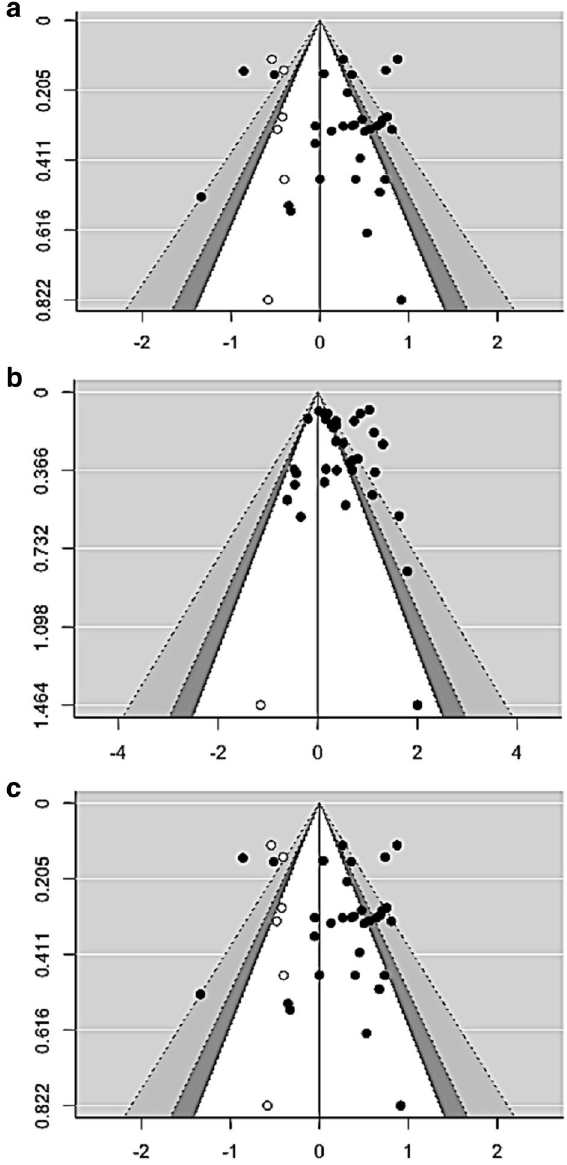
Figure 3. Funnel plots. ( a ) Suicide ideation, ( b ) suicide attempt, and ( c ) suicide death. Filled circles represent observed effects, and open circles represent imputed